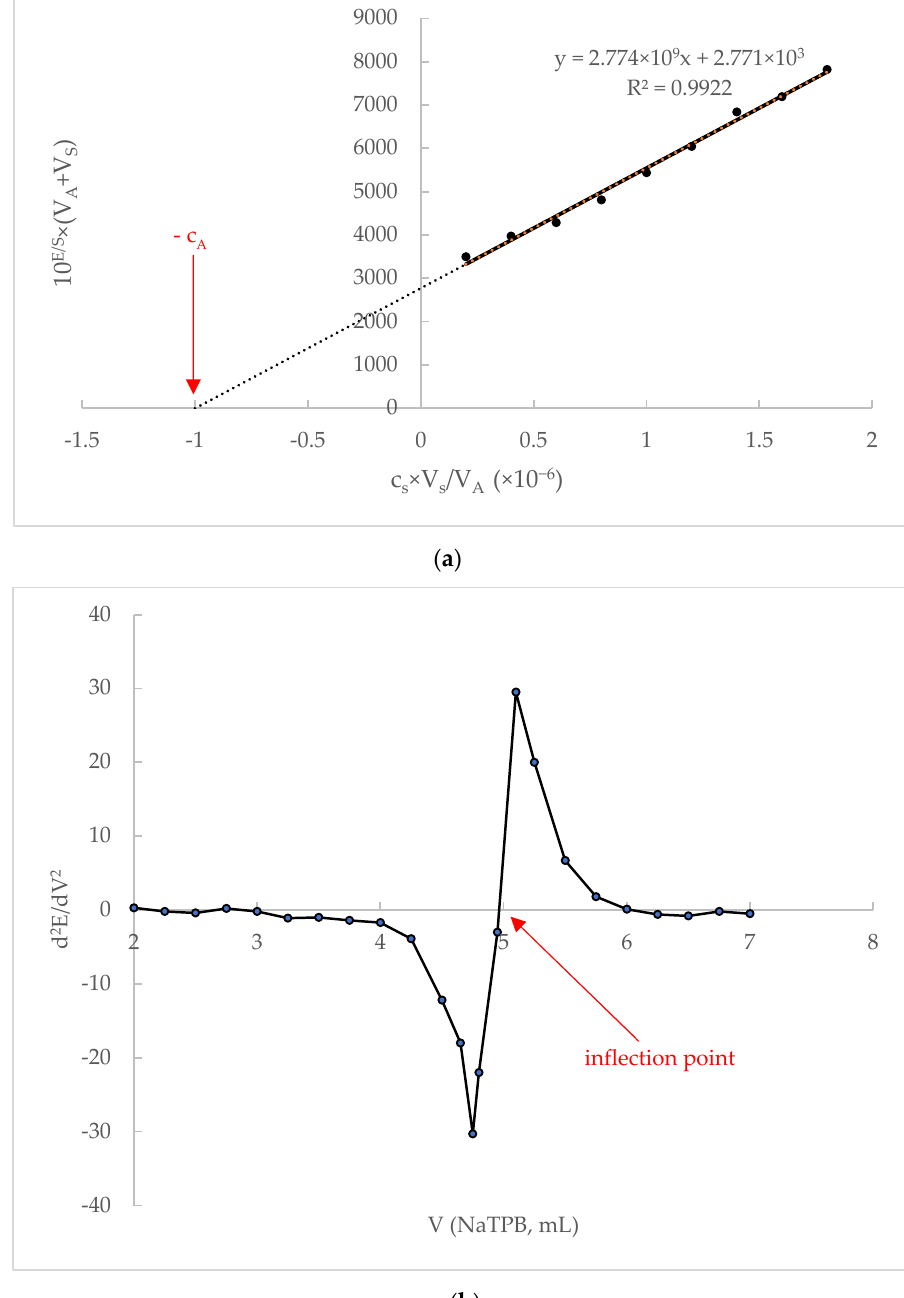
Figure 5. ( a ). Representative graph of the standard addition method application; 1.0 × 10 − 5 mol L − 1 solution of MAP as spike (standard adding solution) was added to a TA of expected MAP concentration of 1.0 × 10 − 6 mol L − 1 . ( b ). Example application of the second order derivate potentiometric titration curve; 50.0 mL of SUSA of expected MAP concentration of 1.0 × 10 − 5 mol L − 1 titrated with 1.0 × 10 − 4 mol L − 1 NATPB solution.